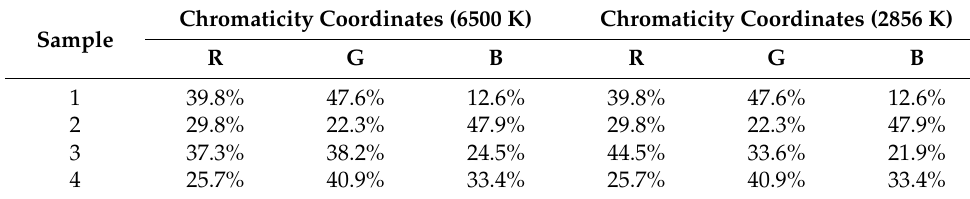
Figure 5. CIE chromaticity diagram of samples. Table 3. CIE chromaticity coordinates of samples.